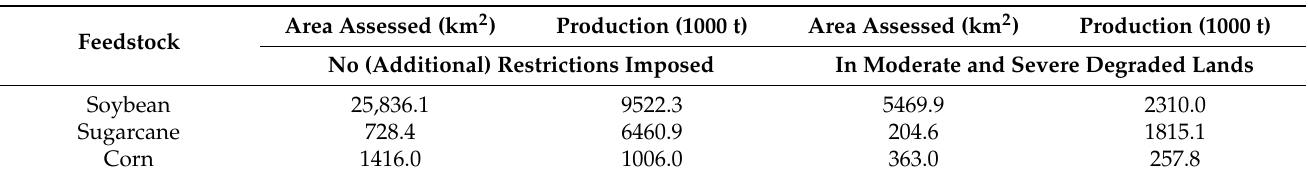
Table 7. The results of the areas assessed for the production of soybean, sugarcane and corn in Parana í ba (MS), considering cropping when no restrictions were imposed besides those considered for defining the eligible areas (reference case) and only in degraded pasturelands (moderate and severe